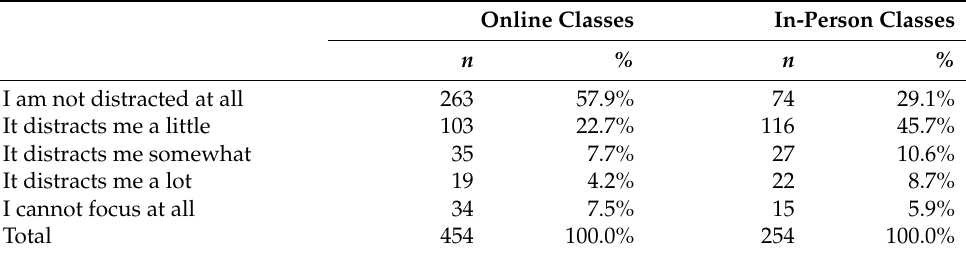
Table 6. How distracted are you when your classmates use their digital devices during class for reasons not related to